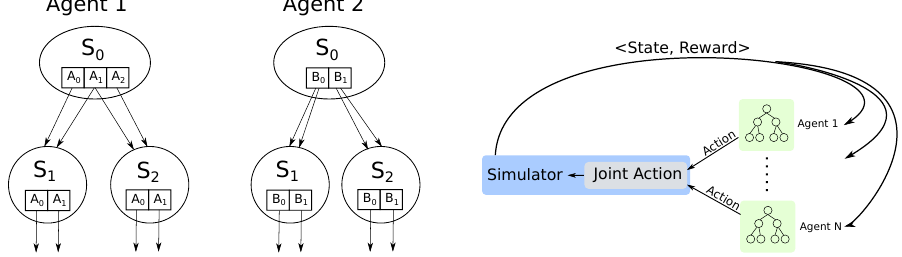
Figure 3. On the left, Decoupled-MCTS with separate search trees for Agent 1 and Agent 2. On the right, the interaction between a simulator and separate search trees in the planning